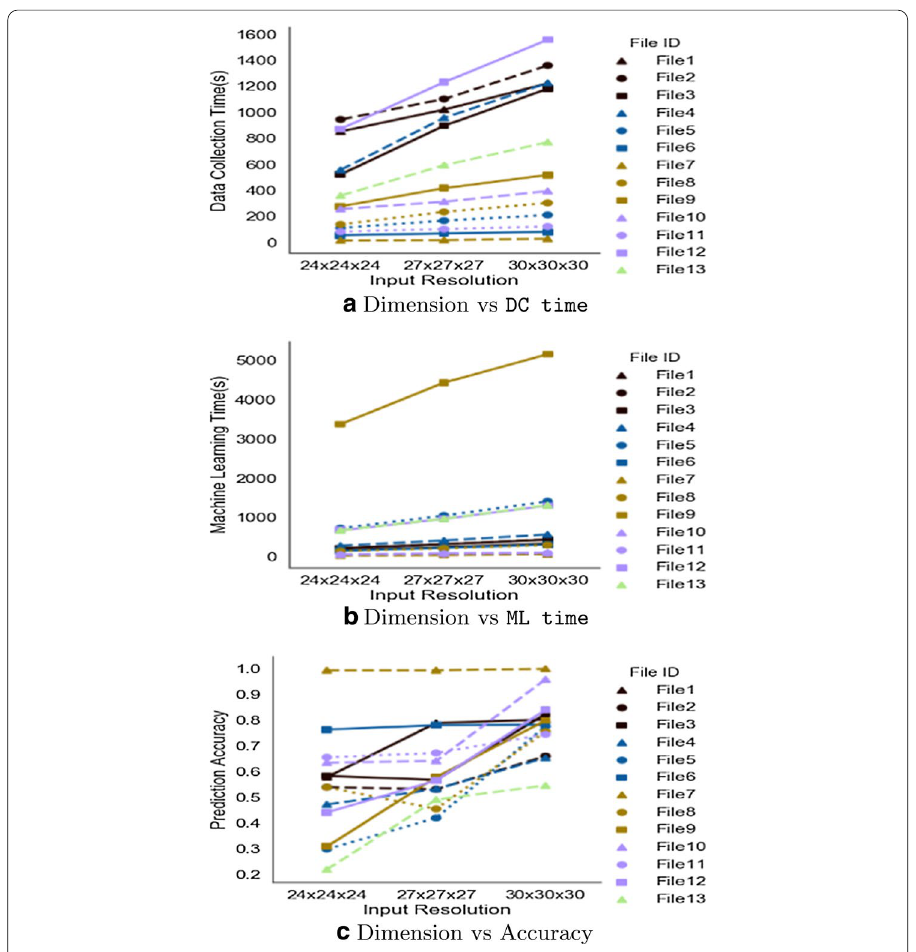
Fig. 14 Impact of different 3D voxel grid